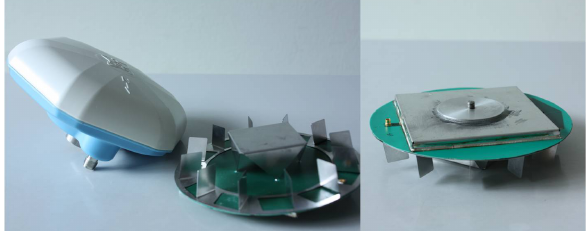
Figure 1: Comparison of the original and the dismantled dual- frequency antenna navXperience 3G+C. The new external refer- ence point is shown in the right section of the